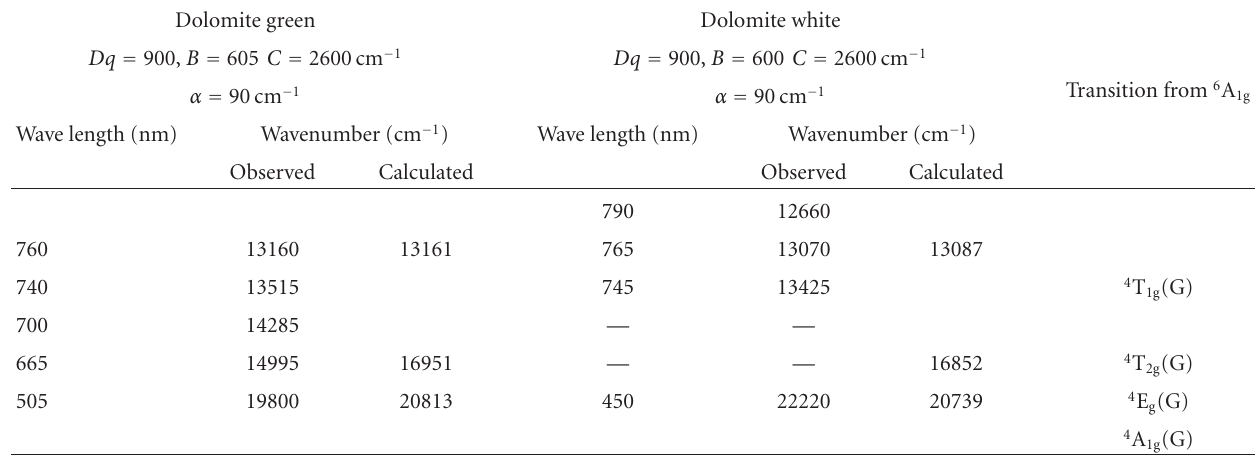
Table 2: Band headed data with assignments for Fe(III) in natural dolomite mineral. Dolomite green Dolomite white